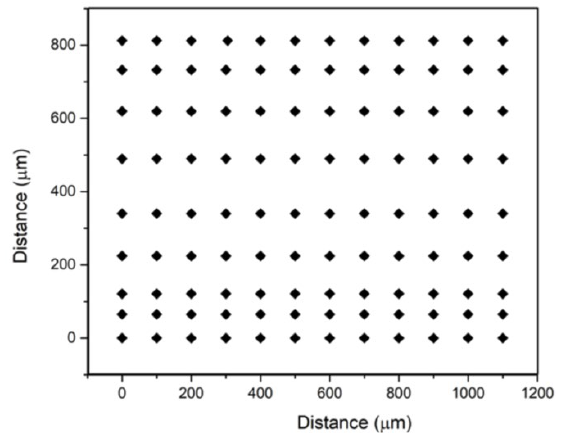
). Figure 2. The matrix for the Vickers microhardness test showing the indentation position ( (cid:7) ♦